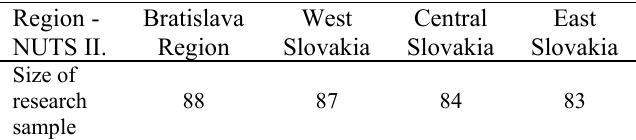
Table 2. Determination of research sample